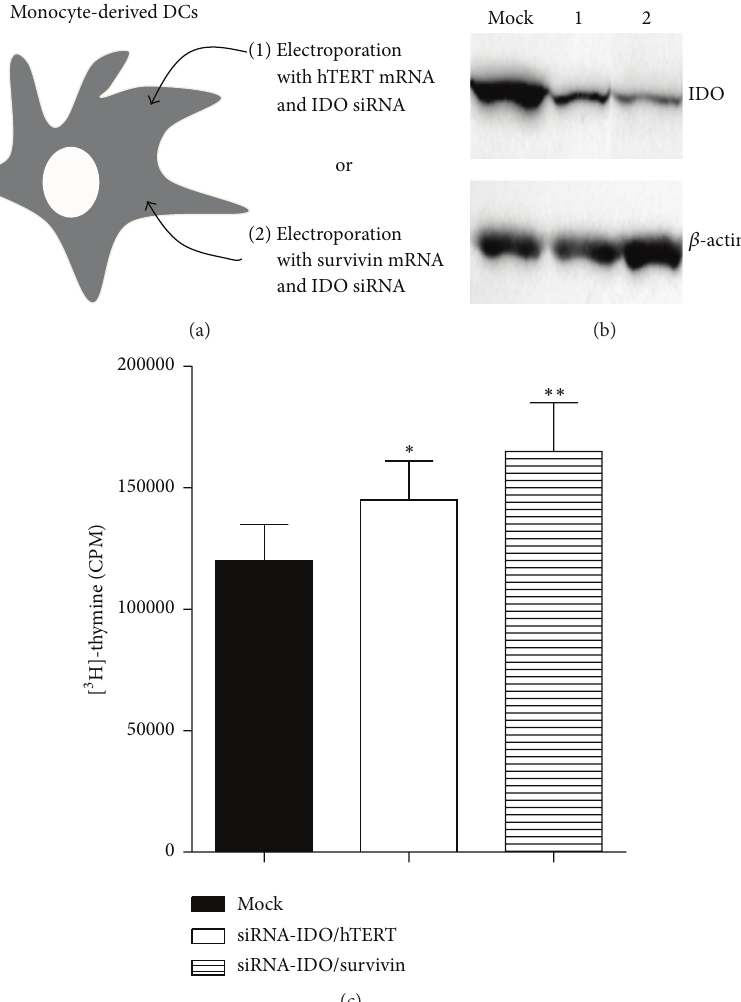
Figure 1: IDO-silenced DC vaccine. (a) Schematic illustration of the vaccine design. (b) IDO gene silencing in the DC vaccine. Fast DC preparationsweretransfectedwithIDOsiRNAunderGMPconditions,asdescribedpreviously[14].At24haftertransfection,IDOexpression was investigated by western blots, and the remaining cells were cryopreserved into vaccine doses and stored in a GMP-dedicated area. Lanes 1 and 2 correspond to DCs transfected with IDO siRNA and mRNA encoding for hTERT and DCs transfected with IDO siRNA and mRNA encoding for survivin, respectively. Mock DCs were not transfected with IDO siRNA. (c) Potency of IDO-silenced DC in stimulating allogeneic T-cells. Patient IDO-silenced DCs and IDO-positive DC vaccine preparations were cocultured with CD4+ T-cells from a healthy donor at a T-cell DC ratio of 1: 5. After 5 days in culture, T-cell proliferation was determined by incorporation of [ 3 H]-thymidine following overnight pulsing. The results are presented as the mean ± standard deviation of triplicate determinations. ∗ 𝑃 < 0.05 and ∗∗ 𝑃 < 0.02 . IDO: indoleamine 2,3-dioxygenase; siRNA: small interfering RNA; DC: dendritic